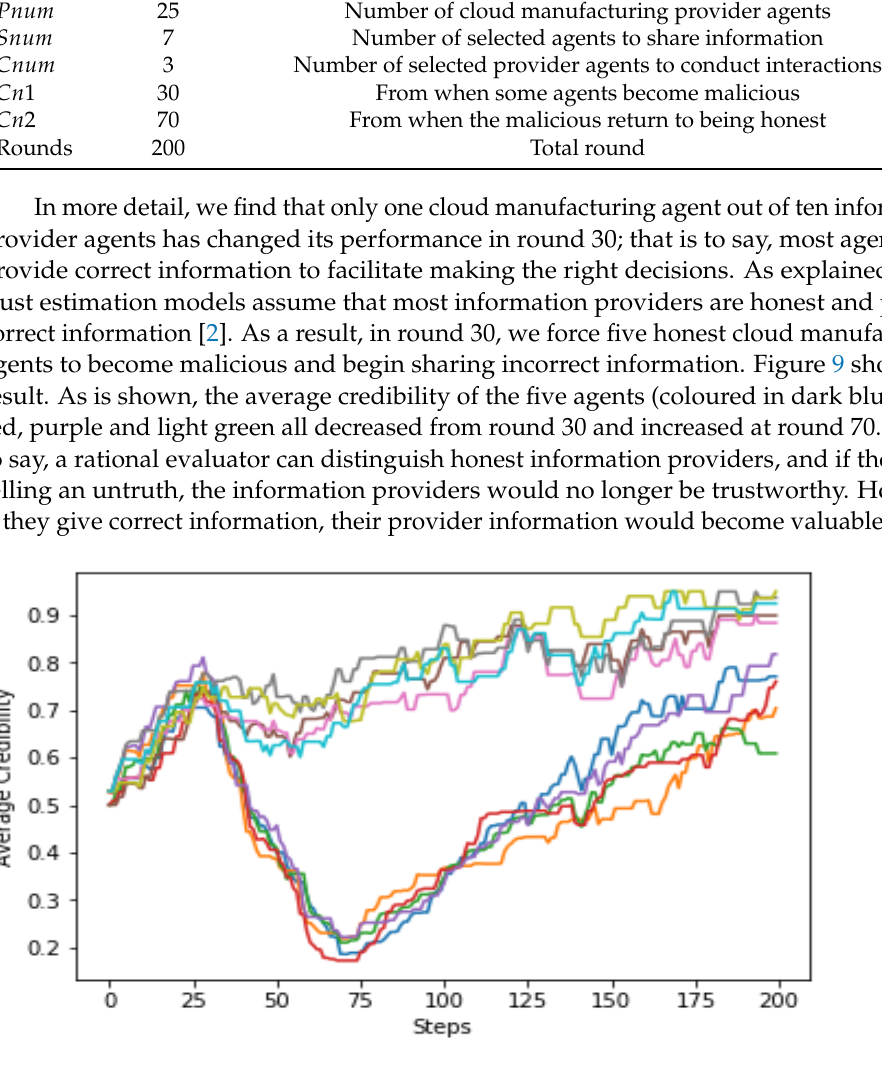
Figure 9. Change in average credibility for each information sharing agent when five agents change their